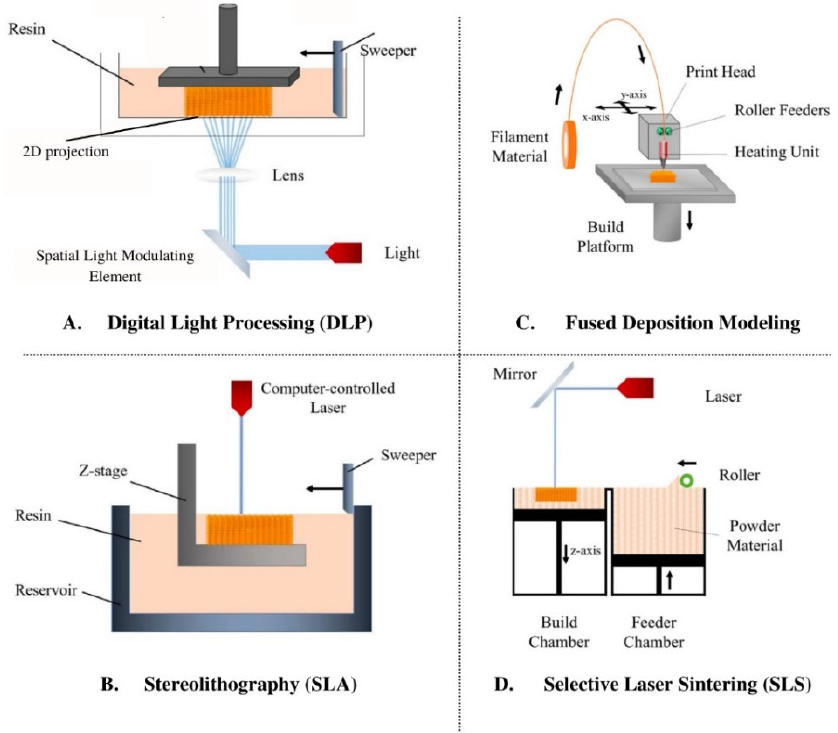
Figure 1. Schematics for four types of 3D-printing: ( A ) Digital Light Processing, ( B ) Stereolithography, ( C ) Fused Deposition Modeling, and ( D ) Selective Laser Sintering. Figure is adapted from Tamay et al., 2019 [81].